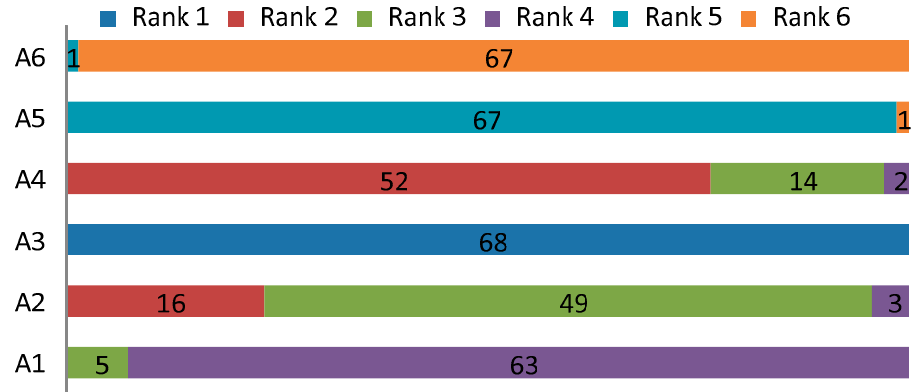
Figure 3. An analysis of the change in the ranking of alternatives through 68 scenarios.